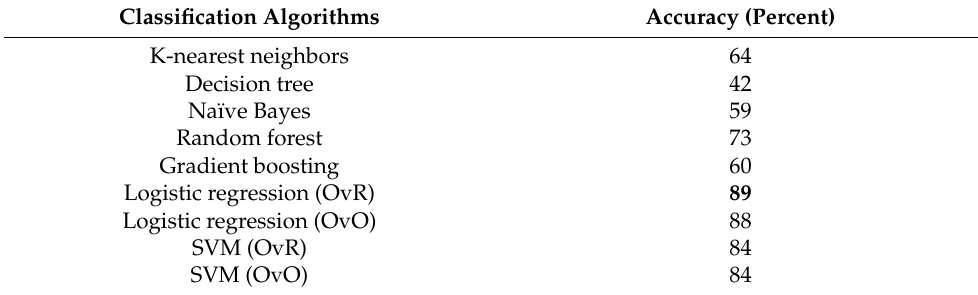
Table 4. Gait recognition accuracy comparison on different classifiers.